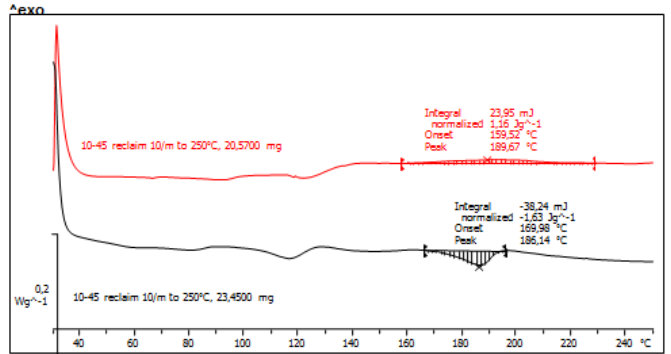
Figure 8. DSC analysis of two reclaimed rubber compounds which do not show any clear evidences of re-vulcanization exotherms.